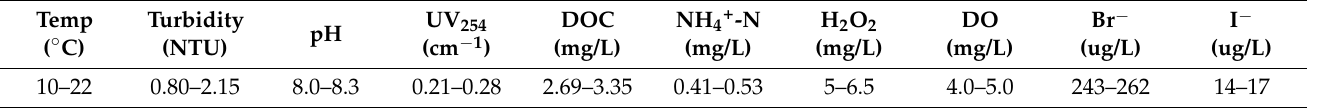
Figure 1. Process flow and structural of UV/H 2 O 2 -biological activated carbon (UV/H 2 O 2 -BAC). Table 1. Characteristics of BAC influent.